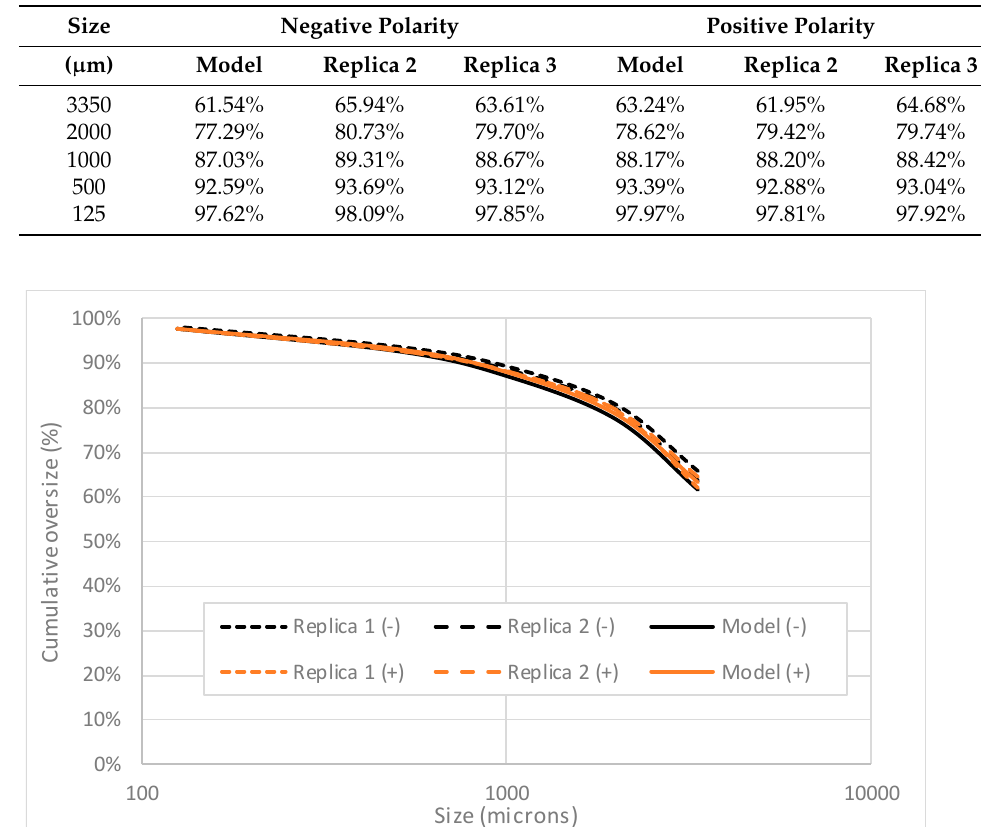
Figure 15. Product PSD after five pulses, monosize 5000/3350 µm.